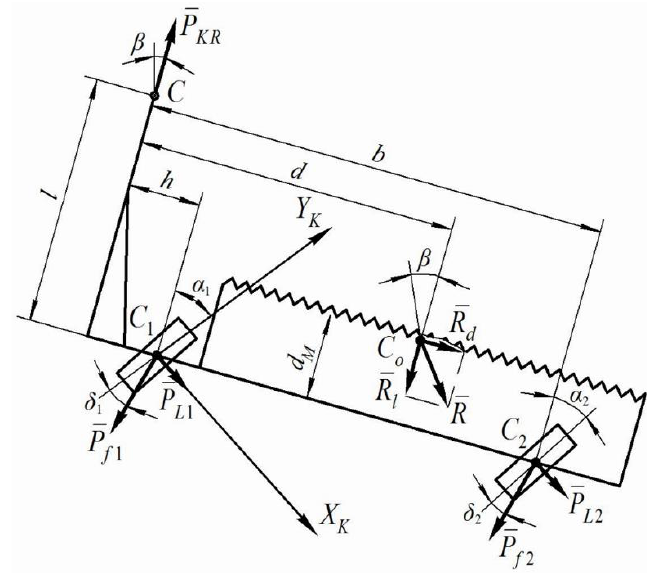
Figure 4. An equivalent diagram of an aggregated windrower.